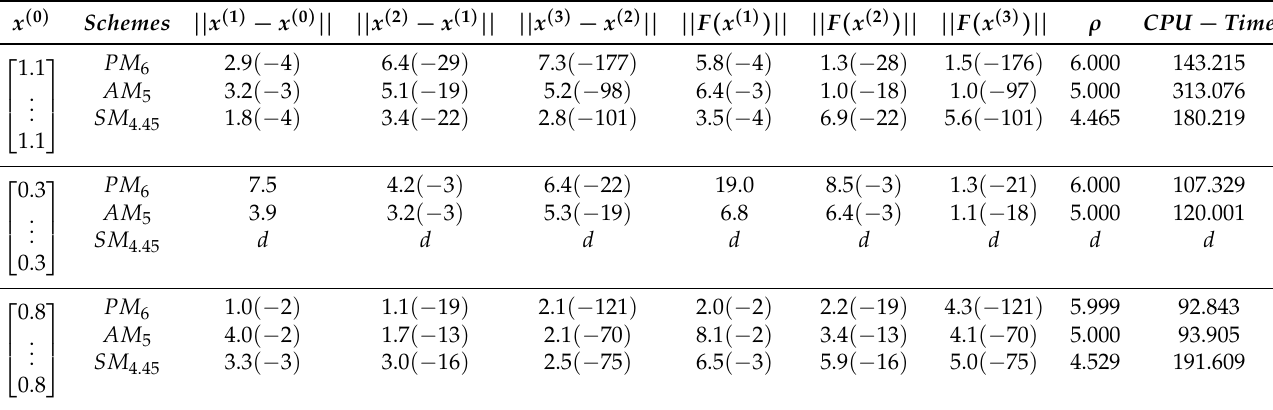
Table 2. Convergence behavior of schemes for Example